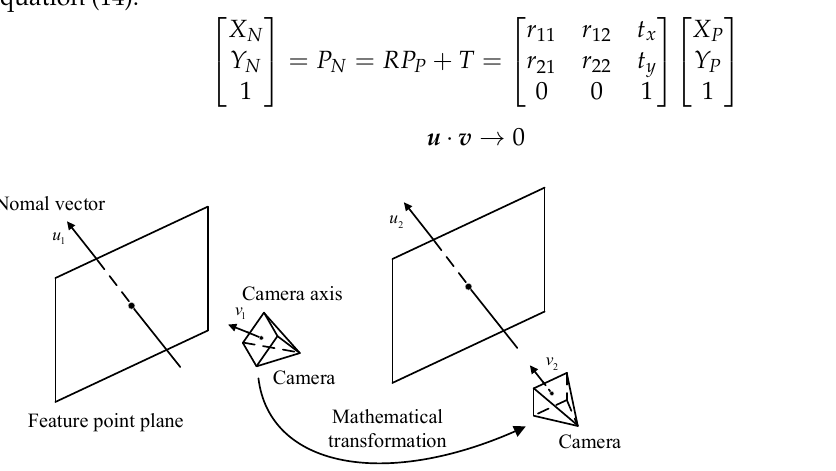
Figure 5. Changes in camera view angle.